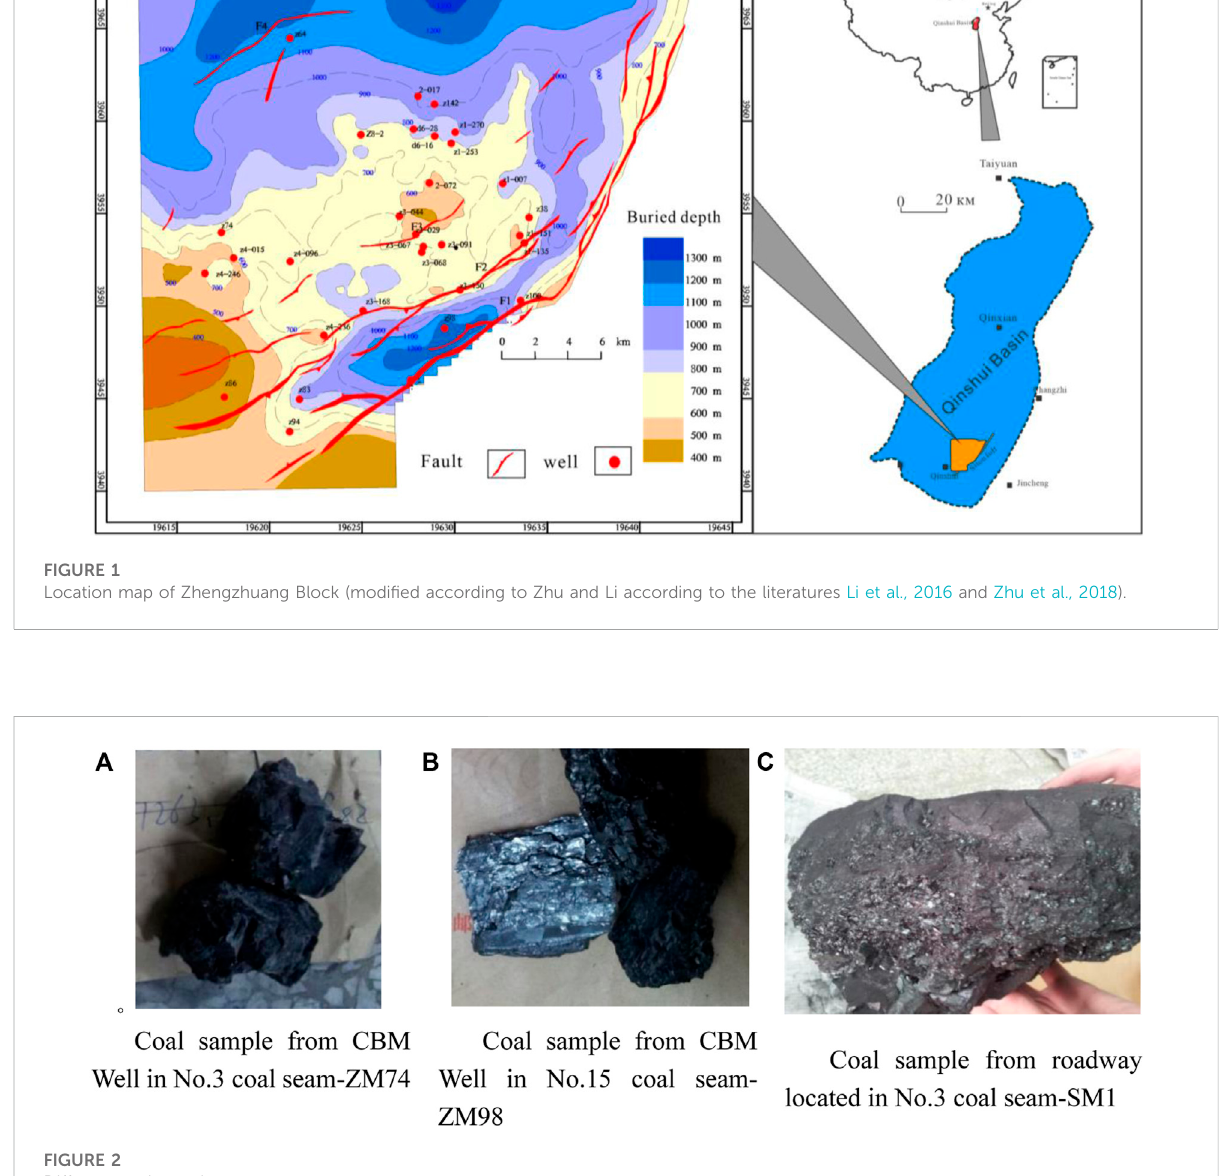
Figure 2. The color of coal in the area is black or gray-black,